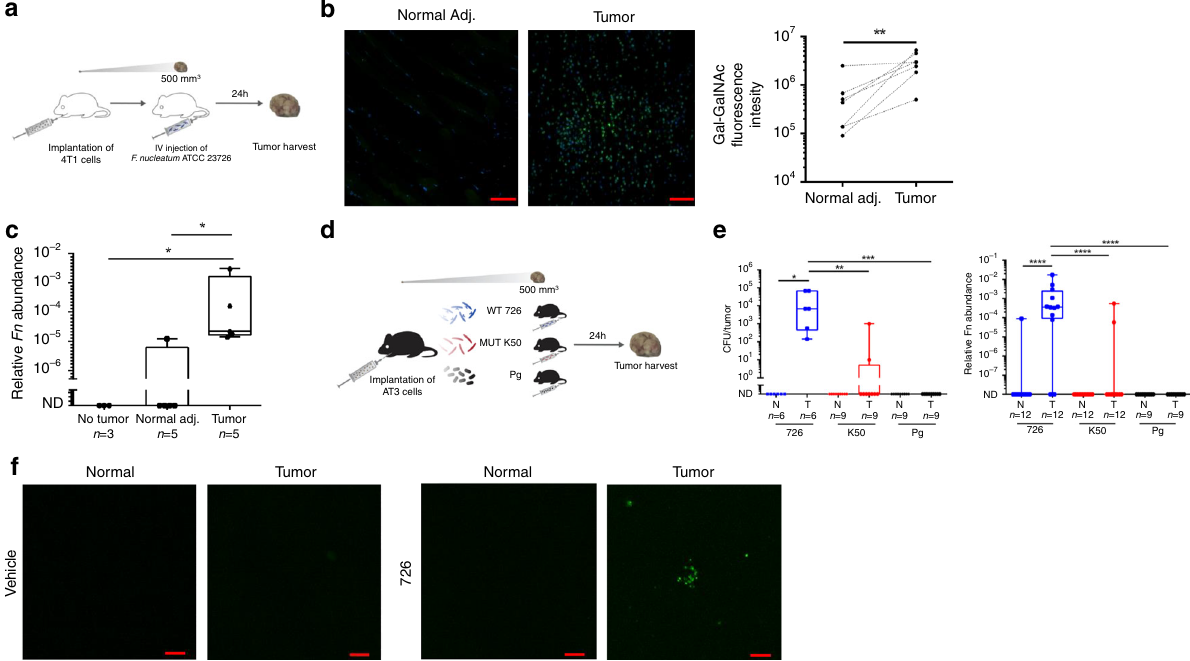
Fig. 4 F. nucleatum colonizes mammary cancer in a Fap2-mediated mechanism. a Orthotropic 4T1 BALB/c mouse mammary cancer model. When reaching 500 mm 3 size, 5 × 10 7 F. nucleatum ATCC 23726 were IV injected. Twenty-four hours post inoculation, breast cancer and normal tissue from an adjacent mammary were harvested. b Representative images and sum of fl uorescence intensity of binding of FITC-labeled PNA (green) to tumor and normal tissue stained with Hoechst dye (blue). Each paired symbols represents one mouse ( n = 7), ** p = 0.0078, one-tailed, Wilcoxon